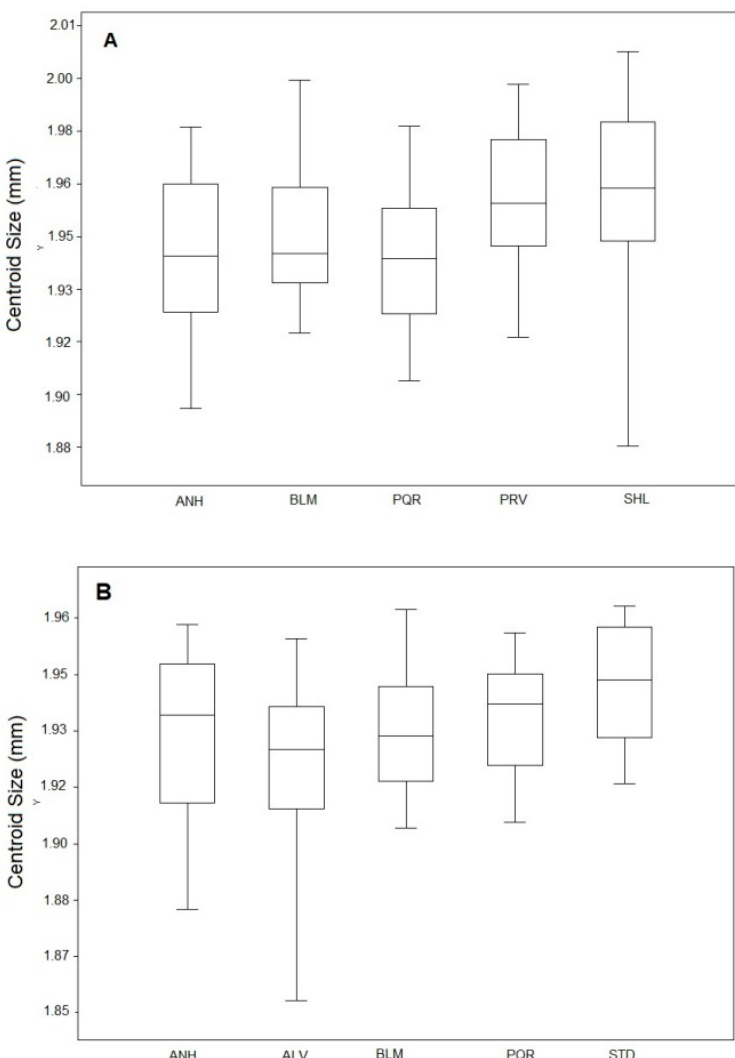
Figure 2. Boxplot graph showing differences in wing centroid size between Ae. scapularis ( A ) and Ae. albopictus ( B ) populations.